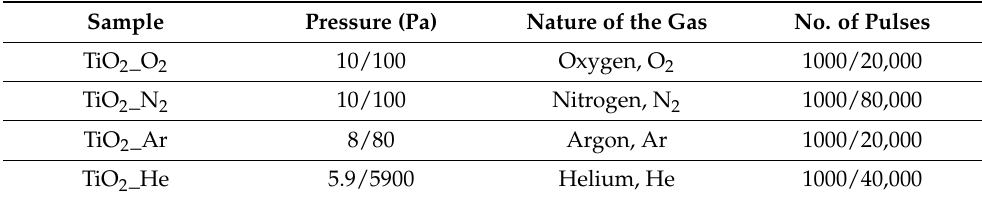
Table 1. PLD deposition conditions of TiO 2